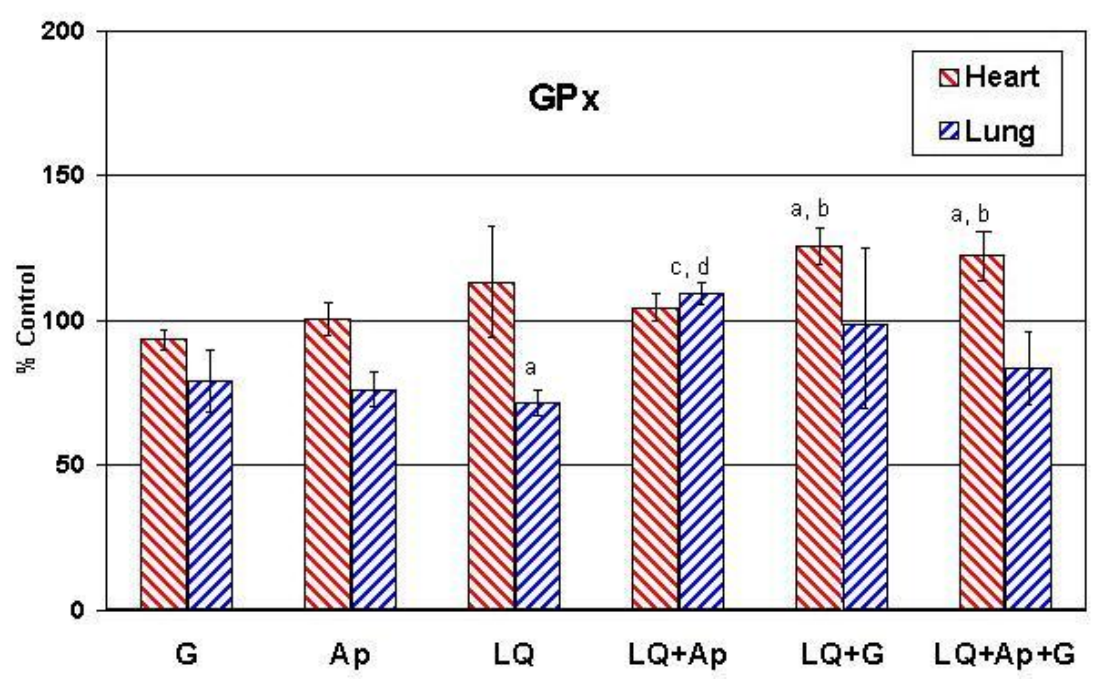
Figure 3: Effects of Leiurus quinquestriatus venom (LQ) alone or after pretreatment with Ginkgo biloba extract (G) and/or aprotinin (Ap) on glutathione peroxide activity (GPx) in the cytosolic fraction of the rat heart and lung homogenates. Mean control values of GPx were 2.83+0.033 and 2.76+0.035 µ mol.min -1 .g -1 wet weight in hearts and lungs, respectively. Bars represent mean of 8 animals and vertical lines indicate SEM. Letters represent values significantly different from those of saline treated control group ( a , p <0.05) and from groups treated with G ( b , p <0.05), Ap ( c , p <0.05) or LQ ( d , p